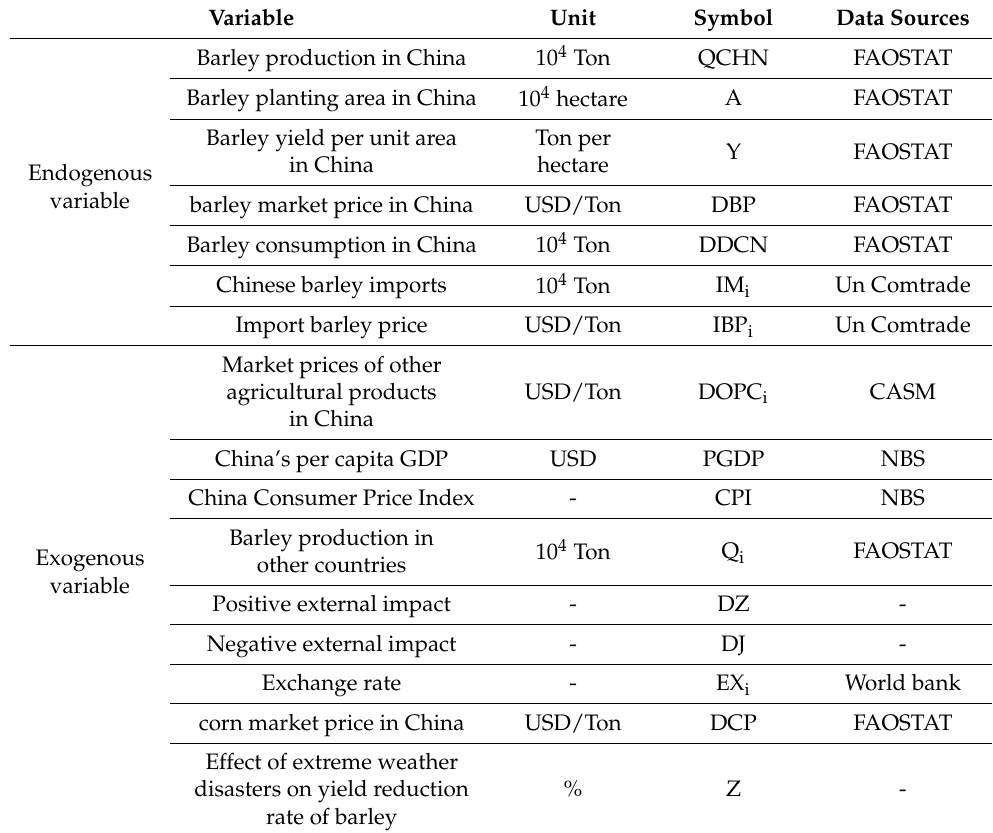
Table 2. Variables and data source.